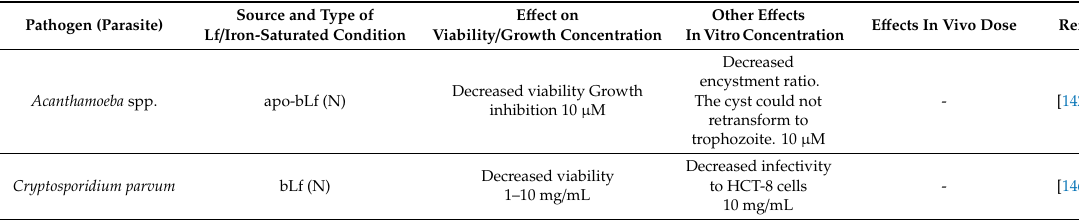
Table 2. E ff ects of lactoferrin and lactoferricins on pathogenic